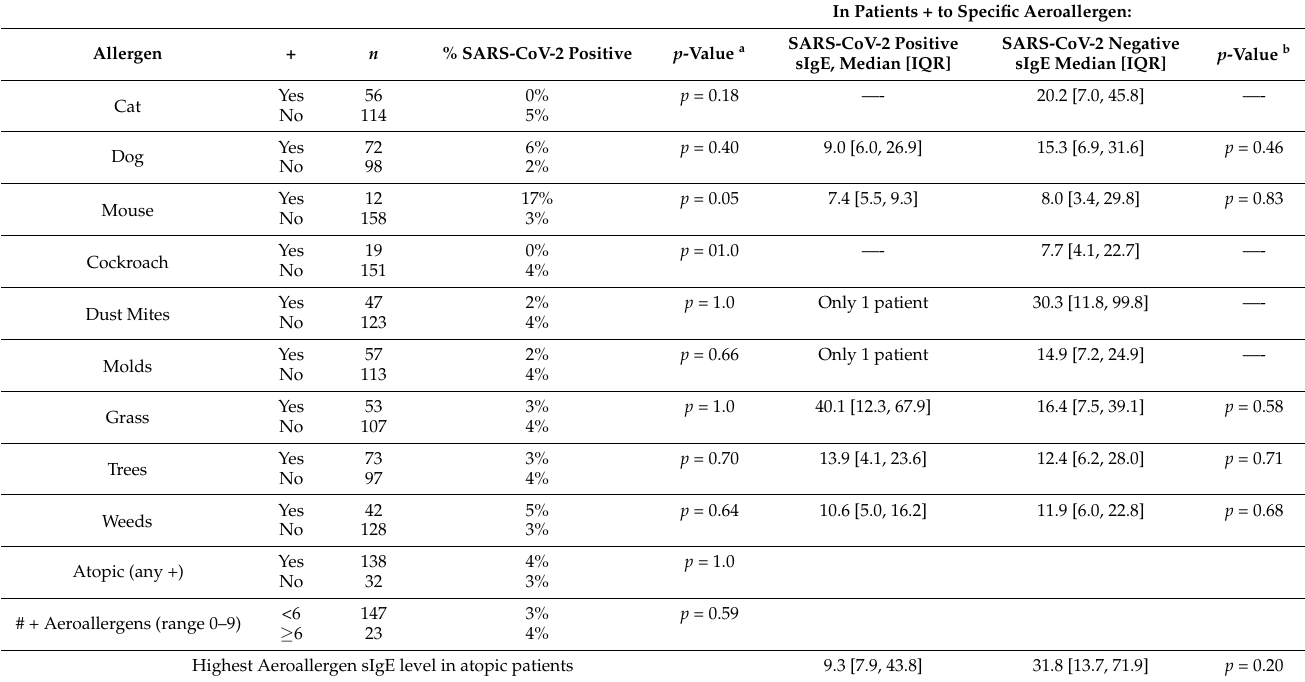
In Patients + to Specific